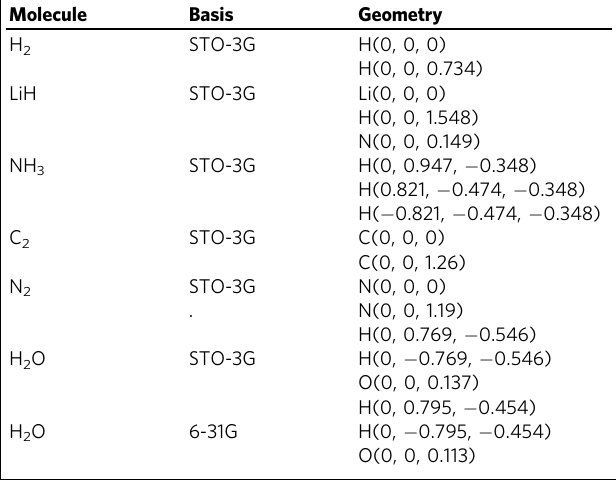
Table 2 Equilibrium con fi gurations used for the ground-state calculations presented in the main text. The coordinates ( x , y , z ) are given in angstroms